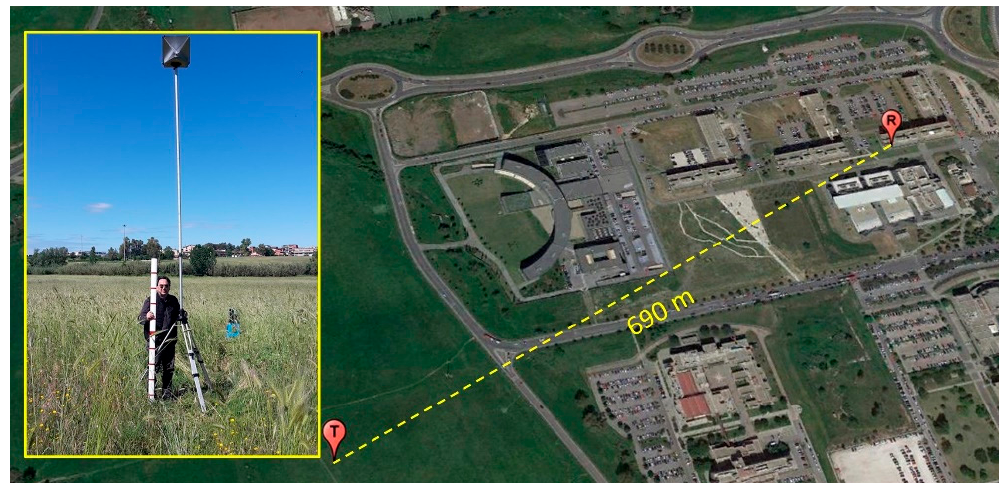
Figure 4. R and T denote the positions of the radar on the roof of the Information building (41°51 ′ 6.40 ″ N, 12°37 ′ 0.50 ″ E) and of the target (41°51 ′ 6.40 ″ N, 12°37 ′ 0.50 ″ E), respectively. On 16 May 2019, a trihedral CR with an RCS of 7.2 dBm (cid:2870) has been posed (as a target) on a